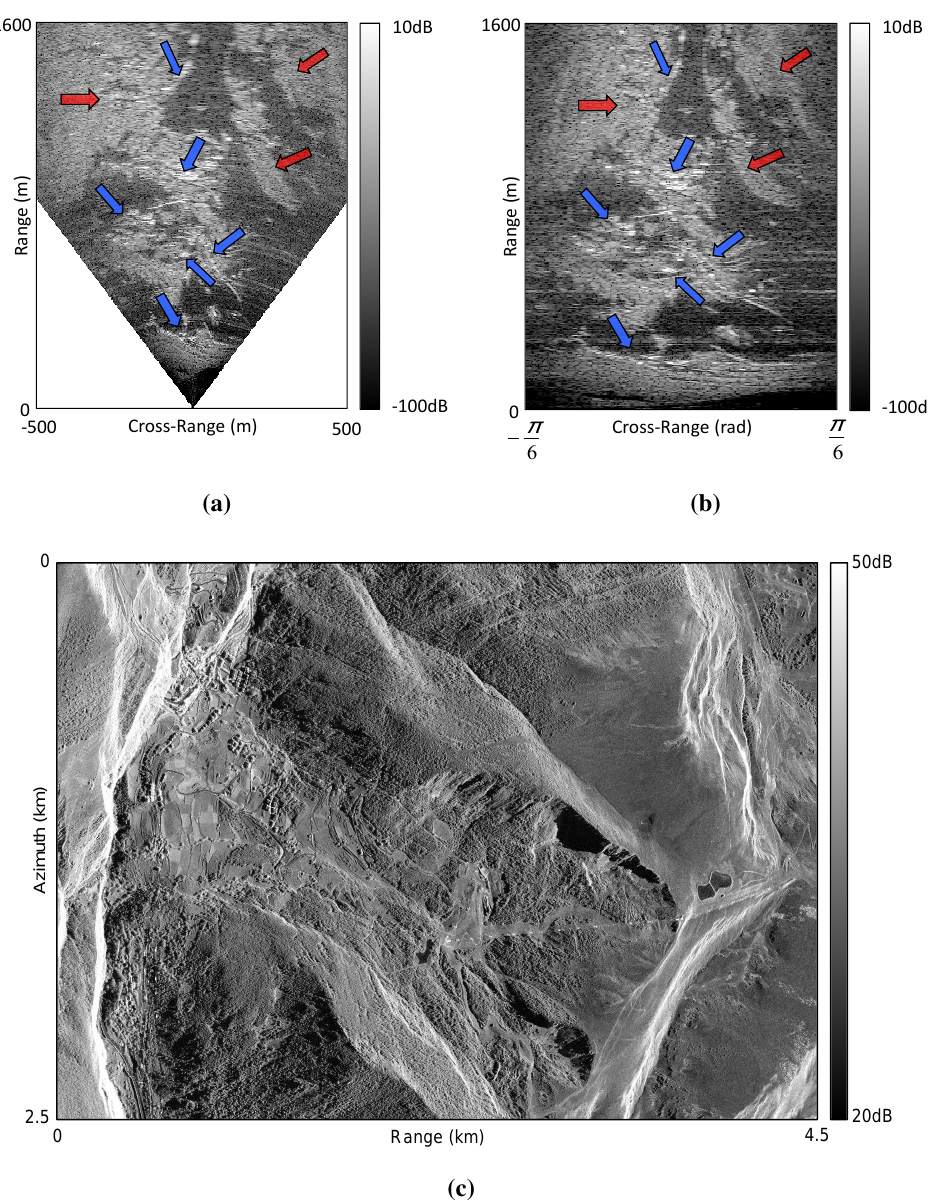
Figure 4. Amplitude in dB covering the lower part of the landslide of El Forn de Canillo of a SAR image collected by the RiskSAR-X sensor in ( a ) cartesian and ( b ) polar coordinates. The blue arrows refer to man-made structures, while the red arrows refer to high-reflectivity areas related to forested areas, which decorrelate fast at the X-band. ( c ) Amplitude in dB of a SAR image collected by the TerraSAR-X sensor in sliding spotlight mode covering the whole sliding